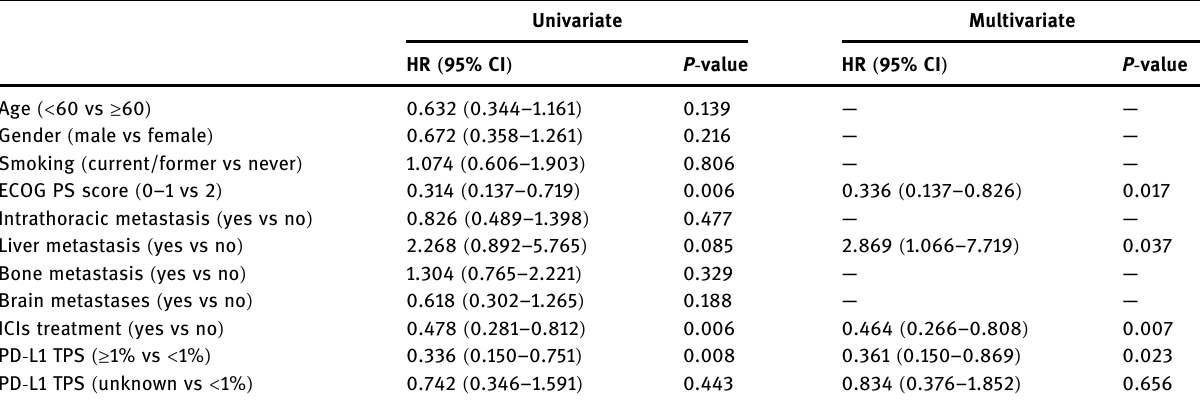
Table 3: Univariate and multivariate analyses of factors associated with OS Univariate